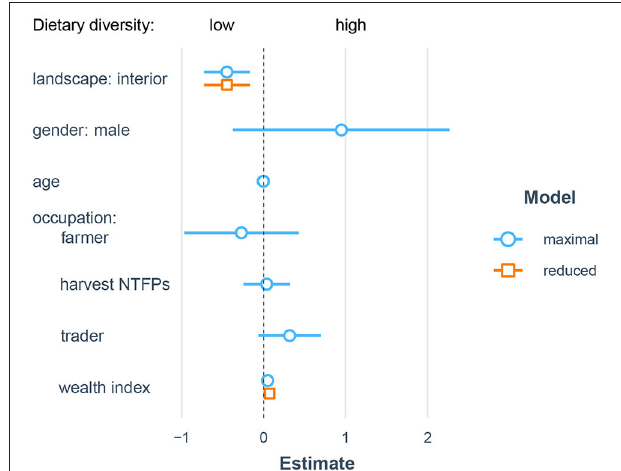
FIGURE 2 | Socioecological predictors of dietary diversity. Results from linear mixed model predicting individual dietary diversity from sociodemographic and landscape differences. Coefficient estimates from full models are shown in blue and coefficients from reduced models retiaing only significant predictors are shown in